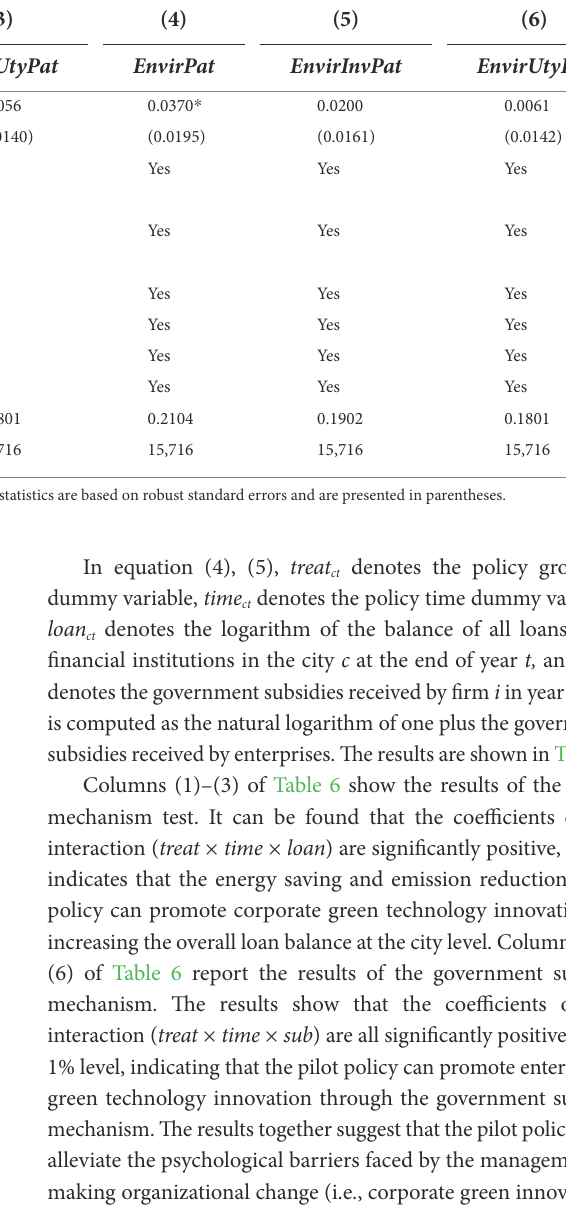
TABLE 5 Robustness tests: excluding confounding